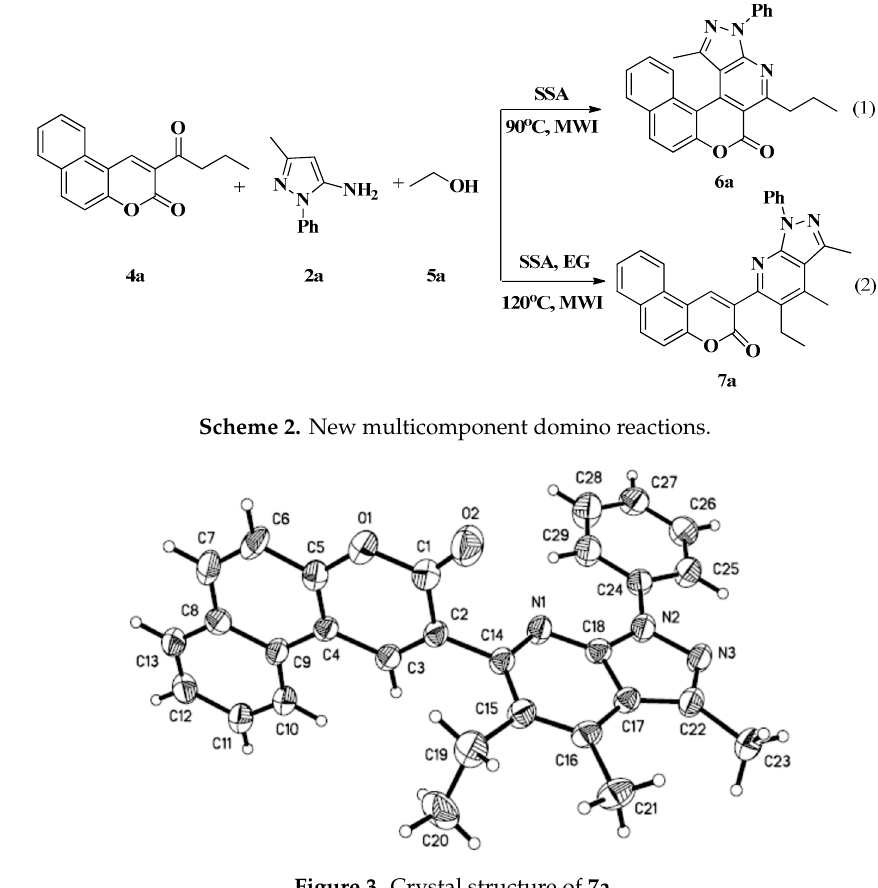
Figure 3. Crystal structure of 7a .